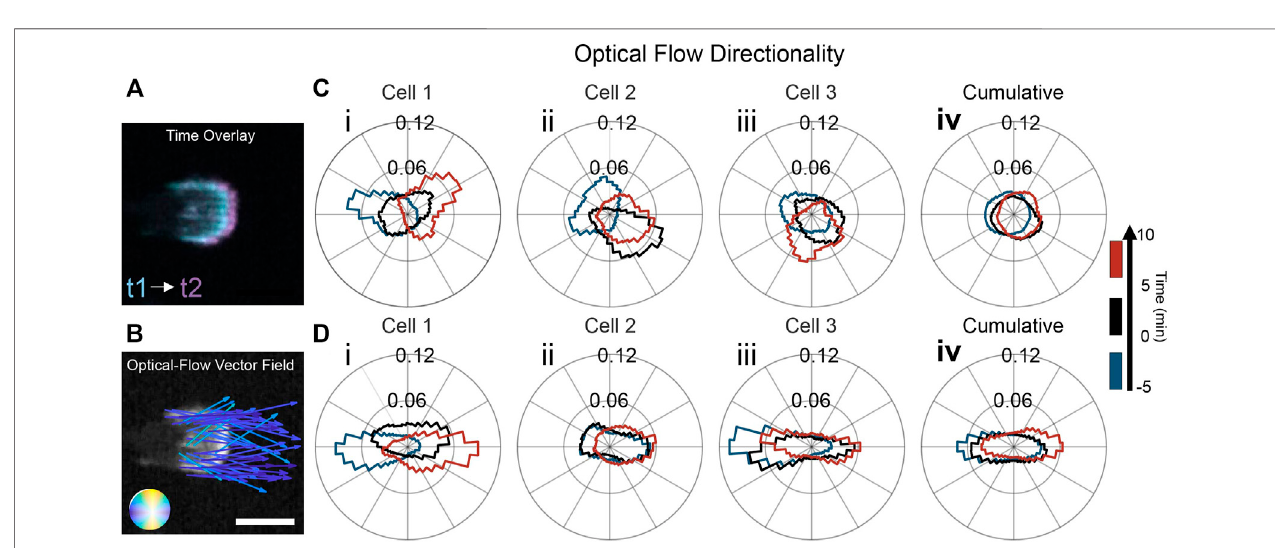
FIGURE2| NanoridgesalignedwithanEFenhancesguidanceofactindynamics. (A) Timeoverlayoftwoactin- fl uorescenceimagesofanHL60cellonnanoridges; the temporal spacing is 0.5 min. (B) Representative optical- fl ow vectors for the motion between the frames in (A) . Scale bars: 10 µm. Three characteristic examples (labeledi-iii)ofindividual,cell-normalizeddistributionsofoptical- fl owdirectionson (C) a fl atsurfaceand (D) nanoridges(ifromcellsin Figure1 )shownforthetimeranges: (blue) 5 min before the EF reversal; (black) 5 min after the EF reversal; and (red) the period from 5 to 10 min after the EF reversal. The cumulative fl ow-direction distribution for the same time intervals for all cells on (Civ) the fl at surface (n = 15) and (Div) the nanoridges (n = 11).